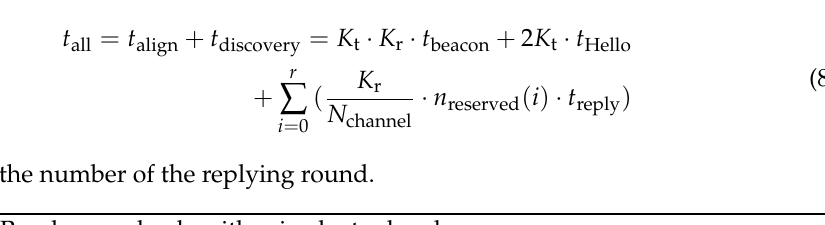
Algorithm 1 Random reply algorithm in cluster